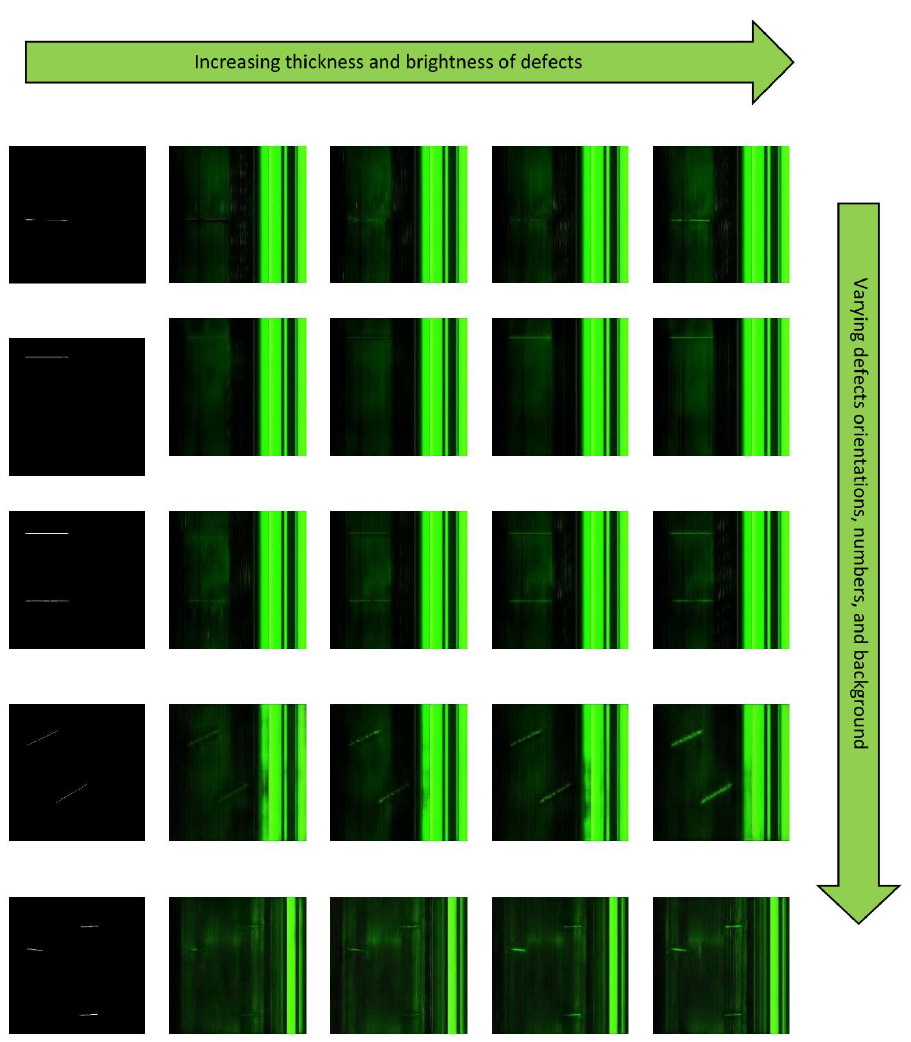
Figure 5. Manipulating Guide vectors on defect dataset. The different rows correspond to different Guide vector settings of fixed mask input and noise.